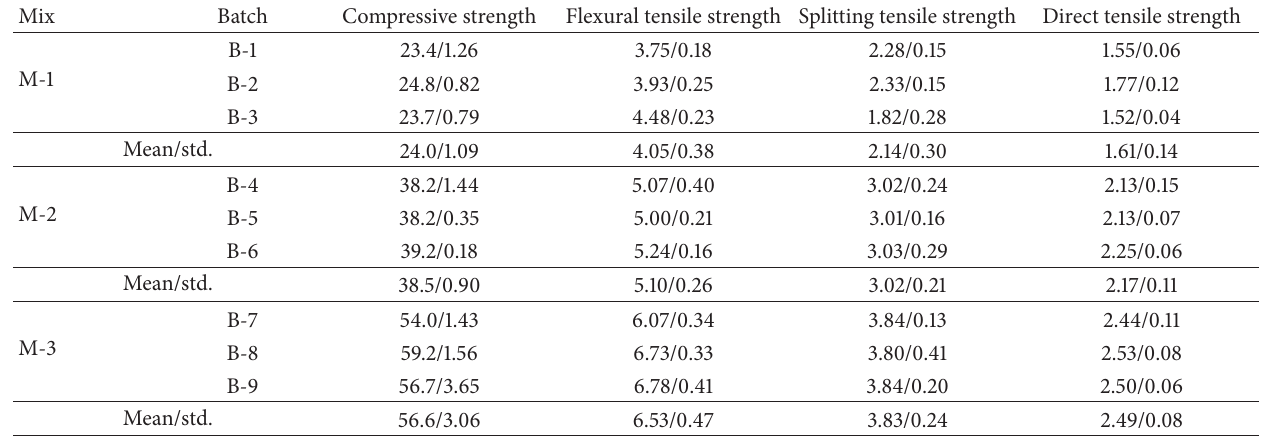
Table 3: Results for direct tension tests presenting mean/standard deviation